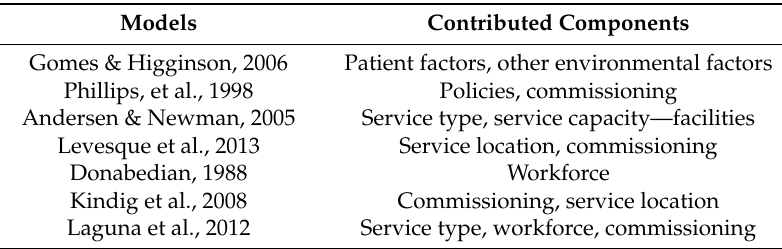
Table 1. The components of the referenced models